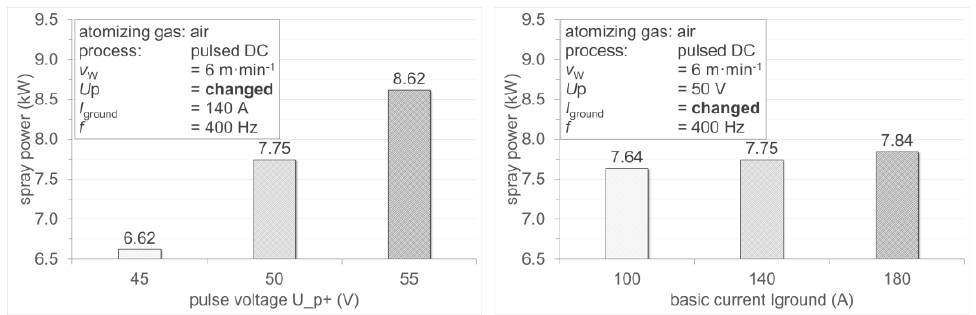
Figure 11. Comparison of the spray power as a function of the pulse voltage ( left ) and the base current ( right ) with pulsed direct current.